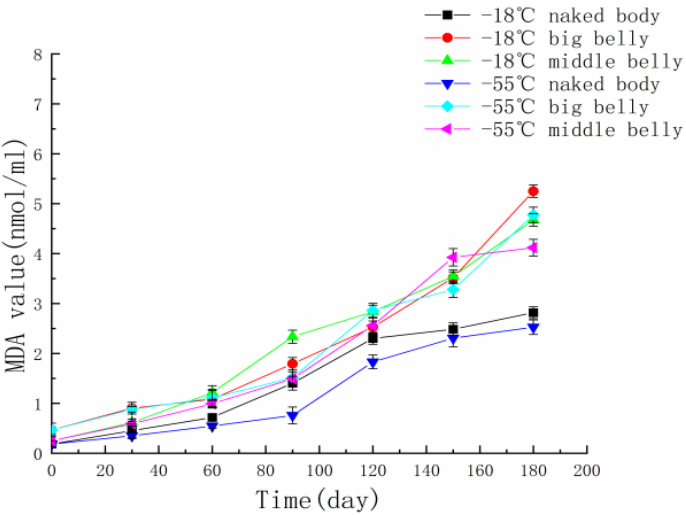
Figure 3. MDA changes in different parts of tuna during frozen storage at different temperatures.